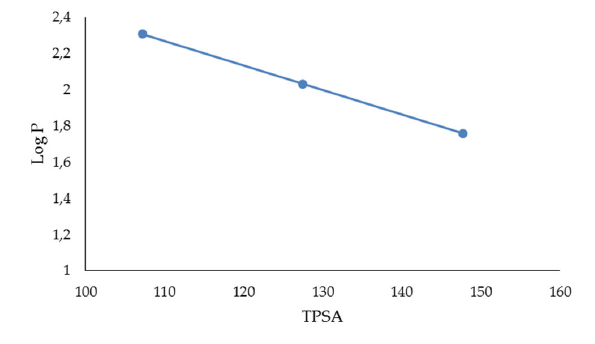
Figure 8. Relationships between the partition coefficient (log P) and topological polar surface area (TPSA) of